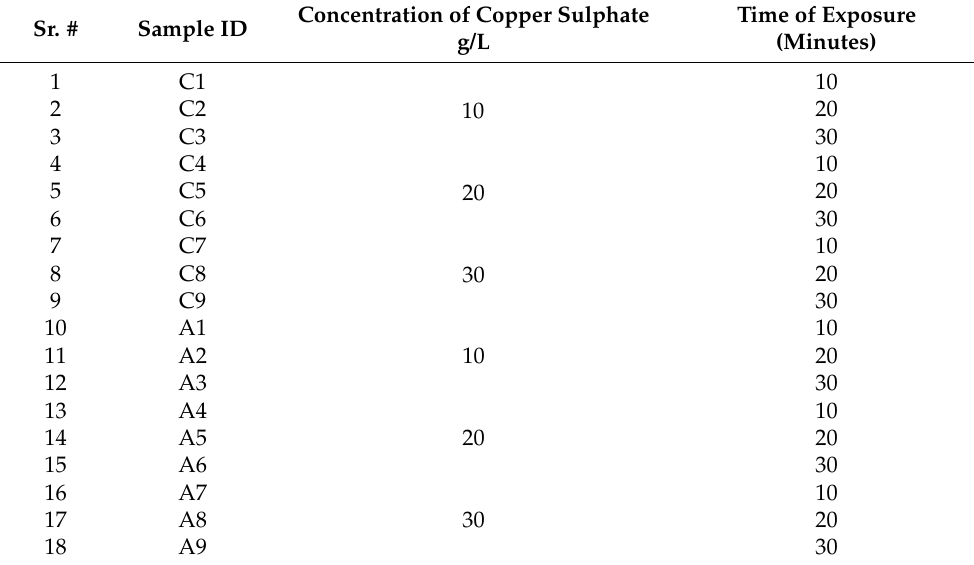
Table 1. The design of the experiment for electroplating the textile samples .